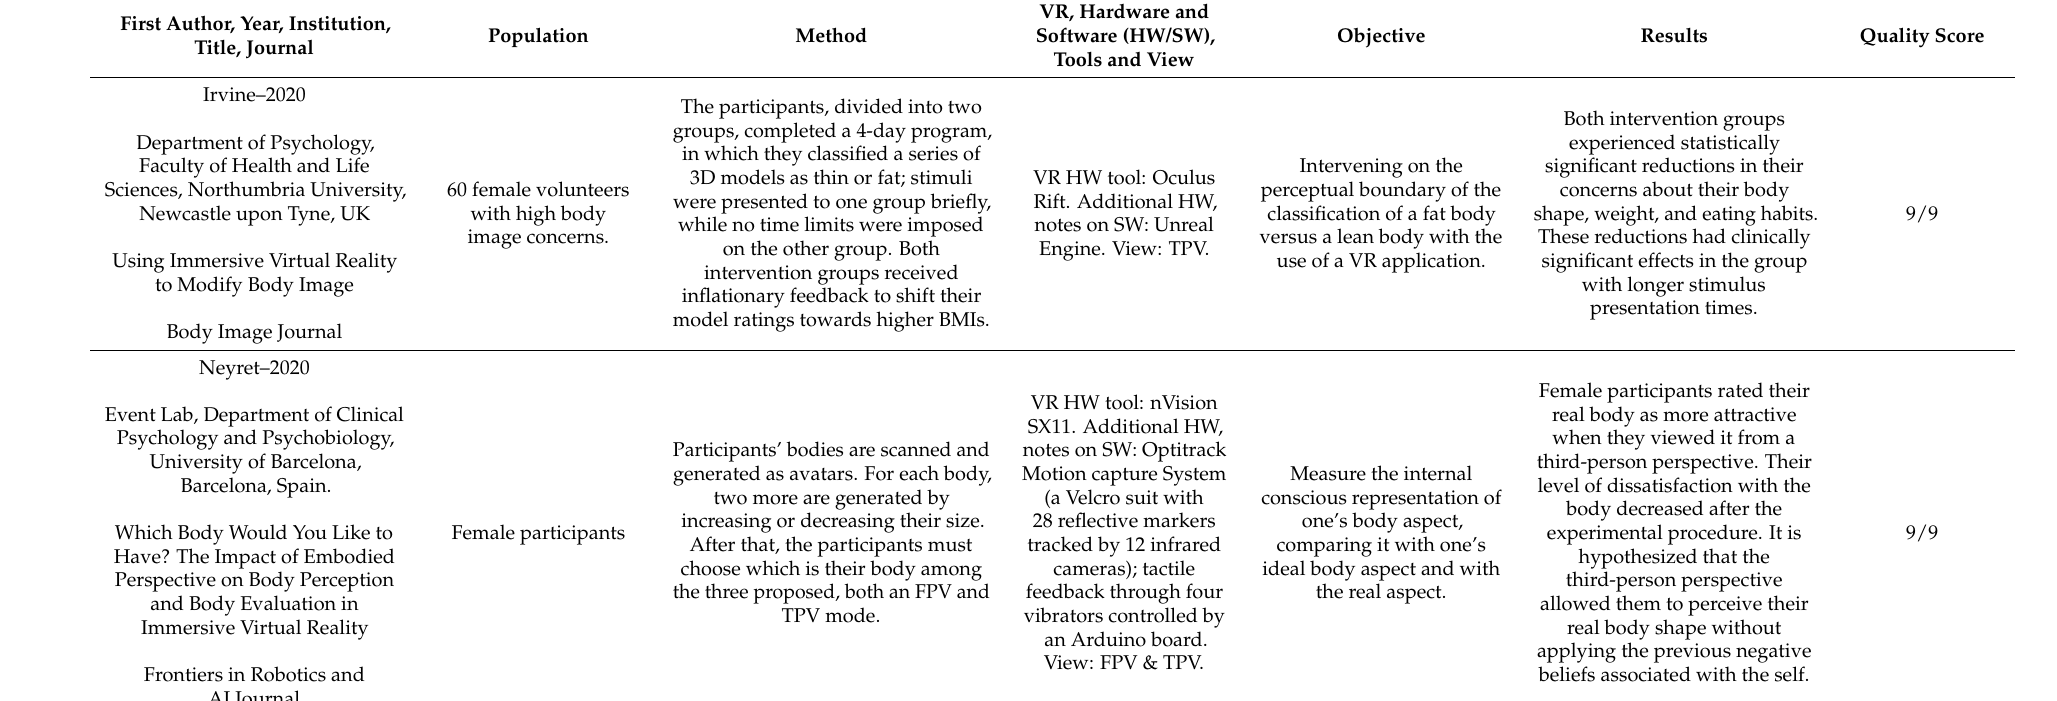
Table 1. Relevant literature in body image perception, anorexia nervosa and virtual reality therapeutic